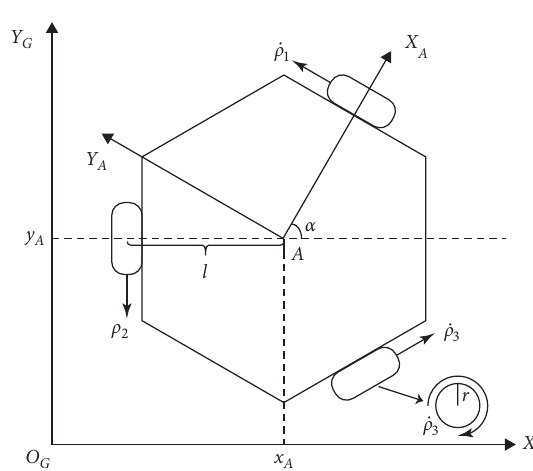
Figure 1: The structure of the mobile platform in the global co- ordinate